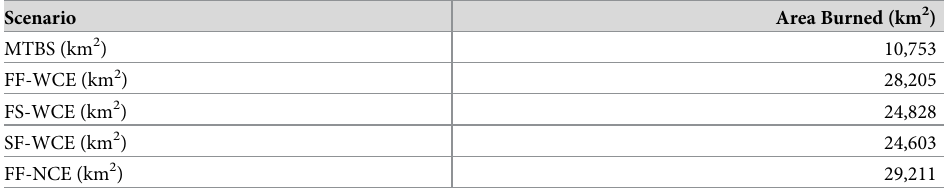
Table 2. Area burned over the period 1985–2012 for MTBS and TAB (total area burned, AWF (area with fire) � FAB (fraction burned)) for with-fire simulations.